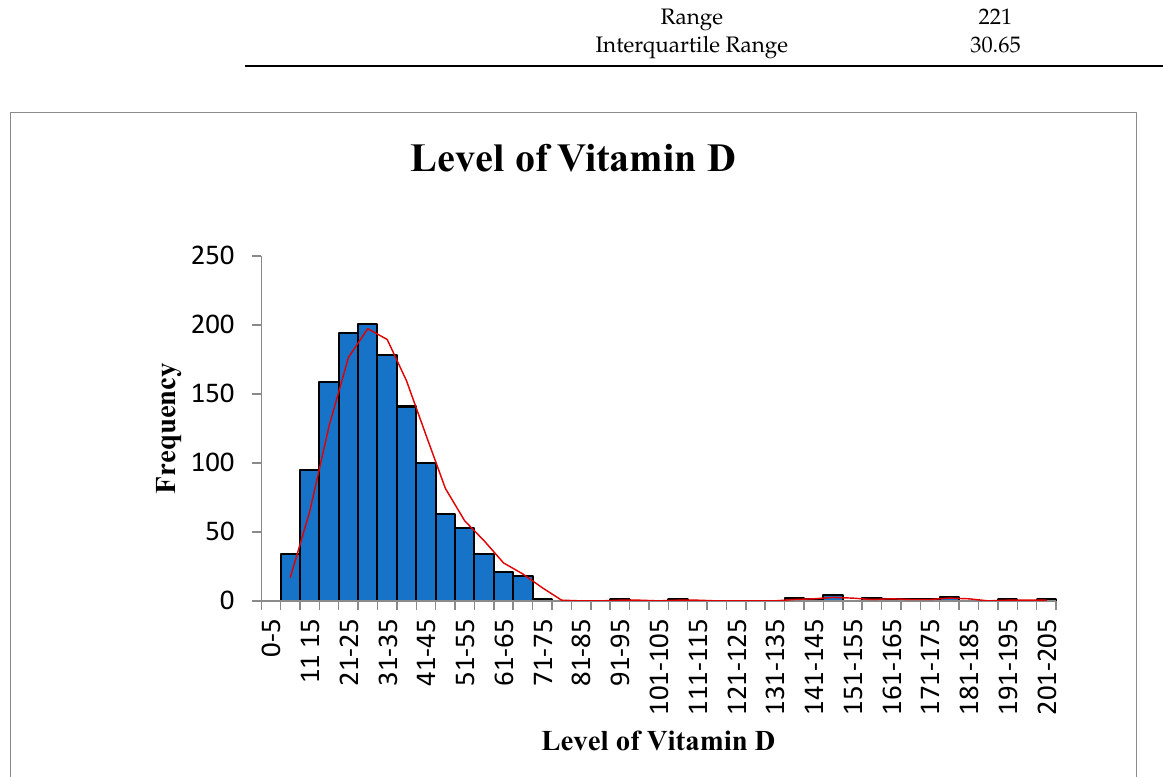
Figure 1. Vitamin D level.